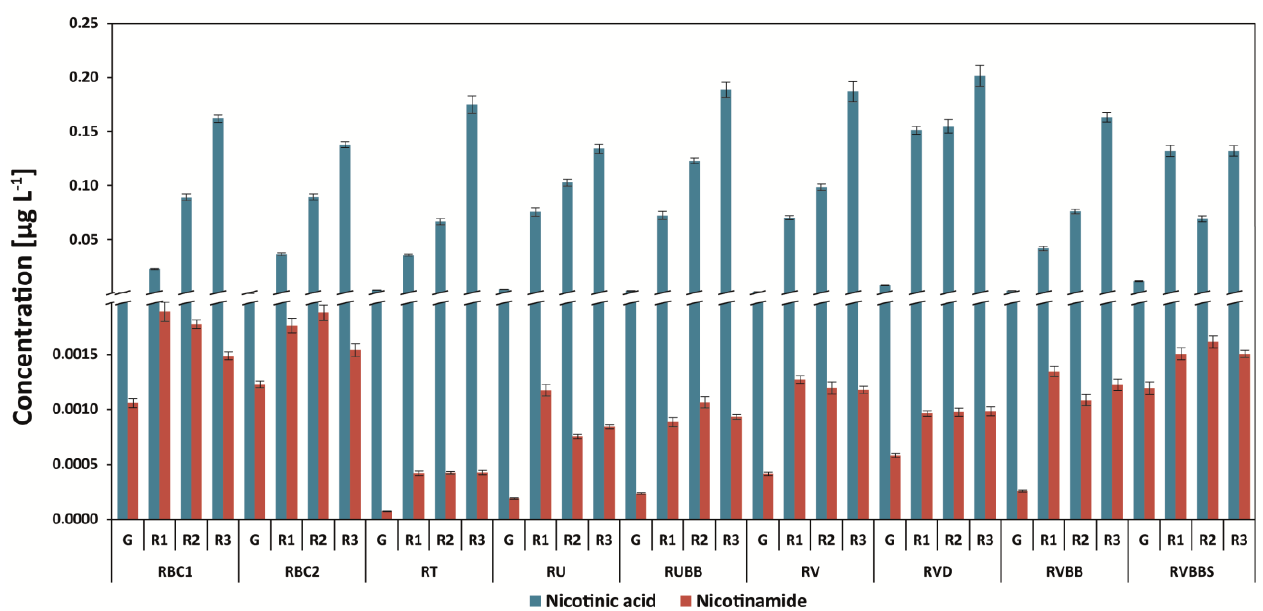
Figure 6. Nicotinic acid and nicotinamide content in Robusta coffee brews. Legend — Figure 1 cap-